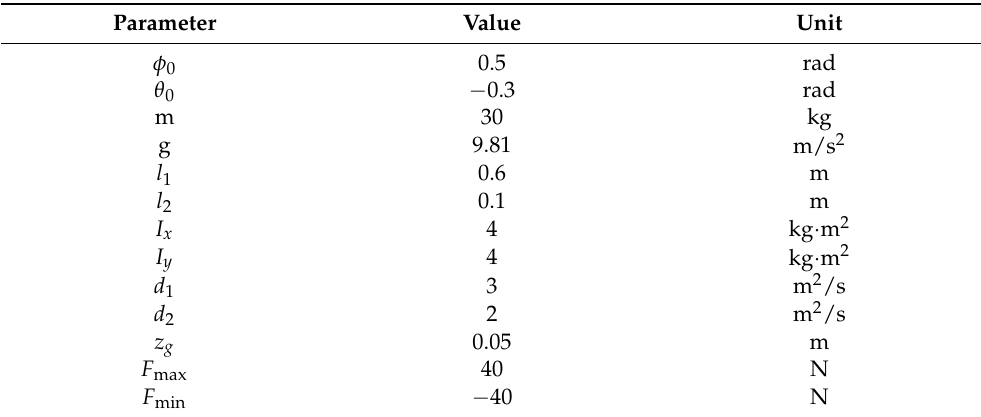
Table 4. Dynamics model parameters.